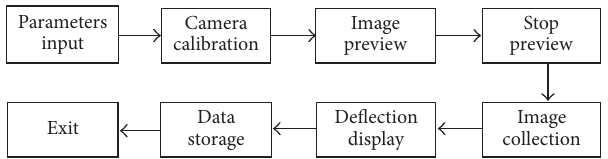
Figure 12: Operation flowchart of deflection monitoring software for Songjiazhuang cloverleaf junction.